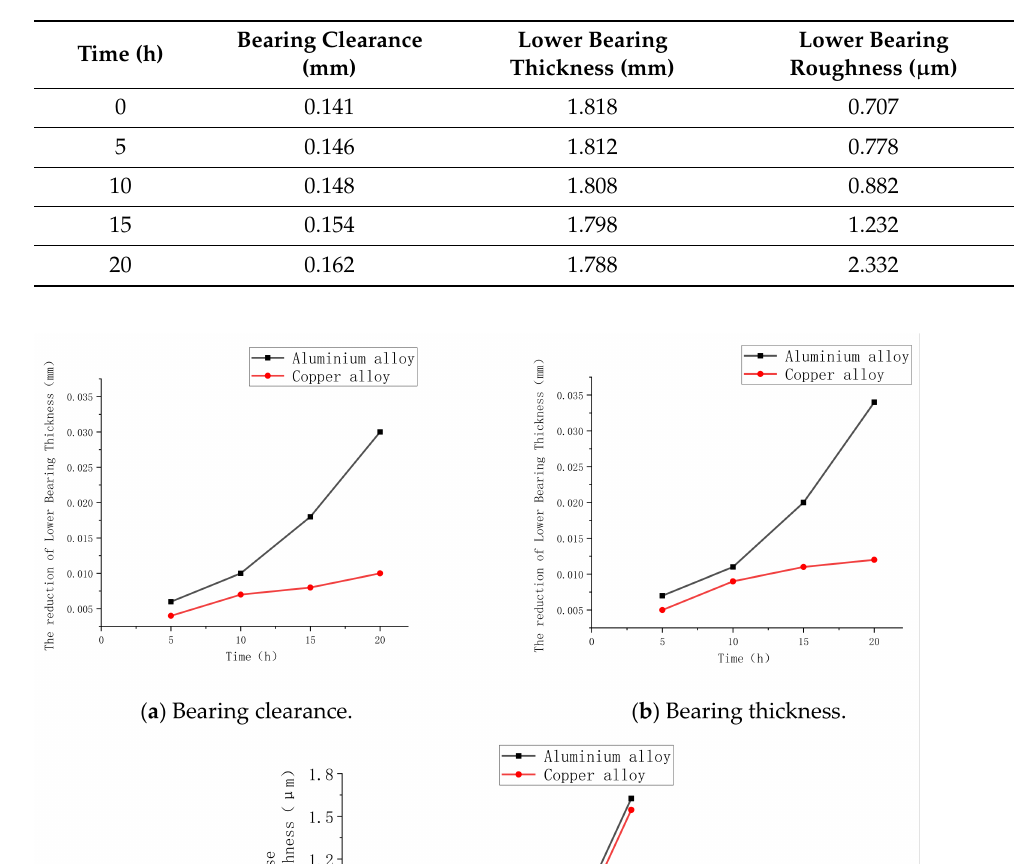
Table 2. The measurement results of the surface condition of the aluminium alloy bearing at different times.